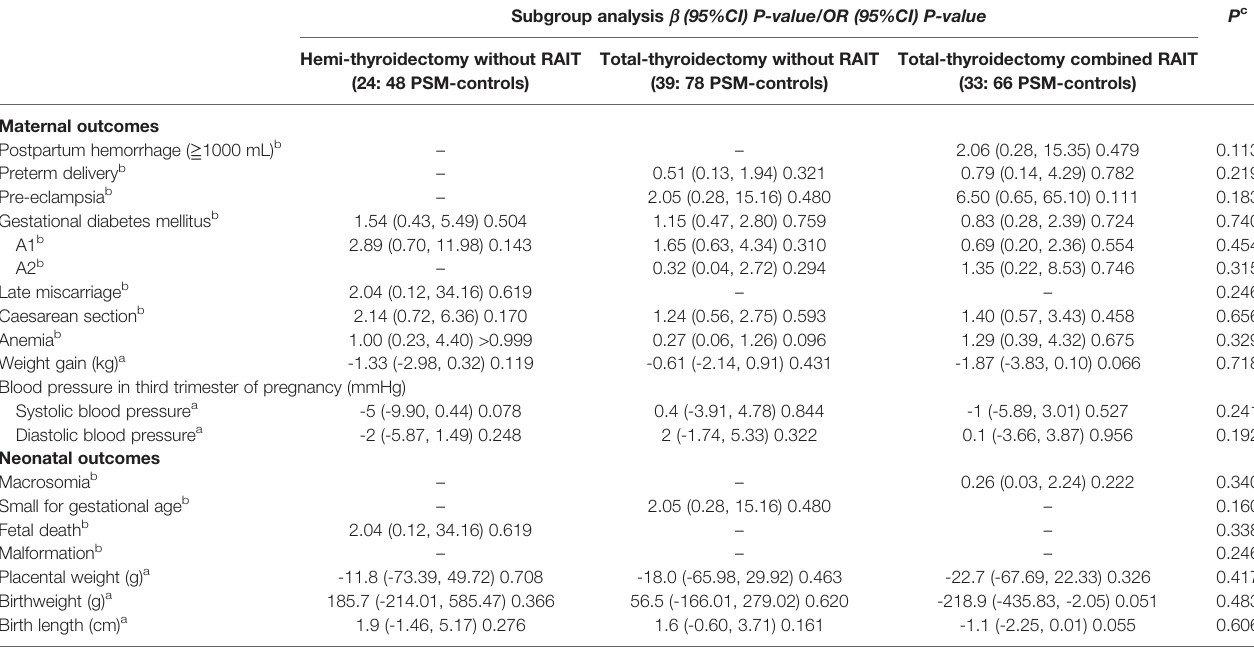
TABLE 5 | Subgroup analysis and comparison of different treatments modality among thyroid cancer survivors.